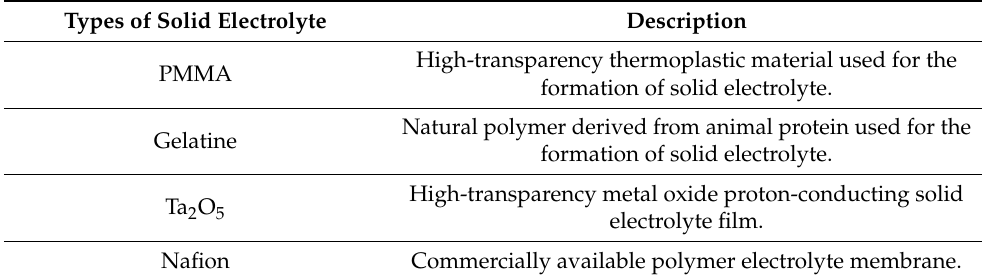
Table 1. List of solid-state electrolyte candidates for ECD application. Types of Solid Electrolyte